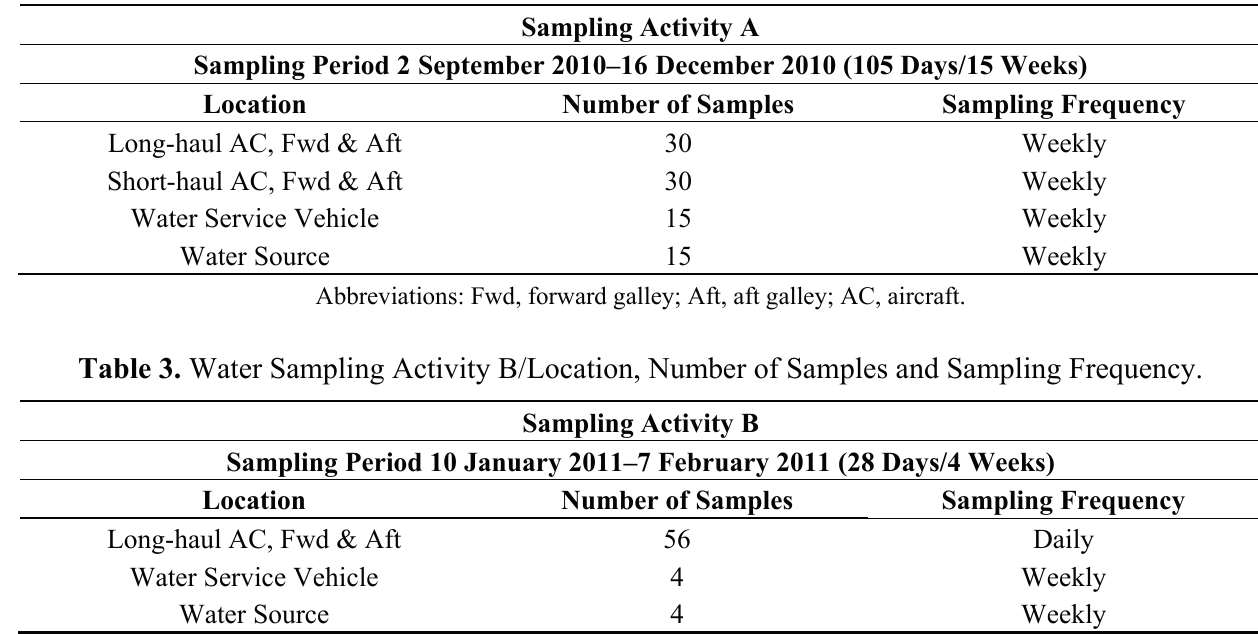
Table 2. Water Sampling Activity A/Location, Number of Samples and Sampling Frequency.